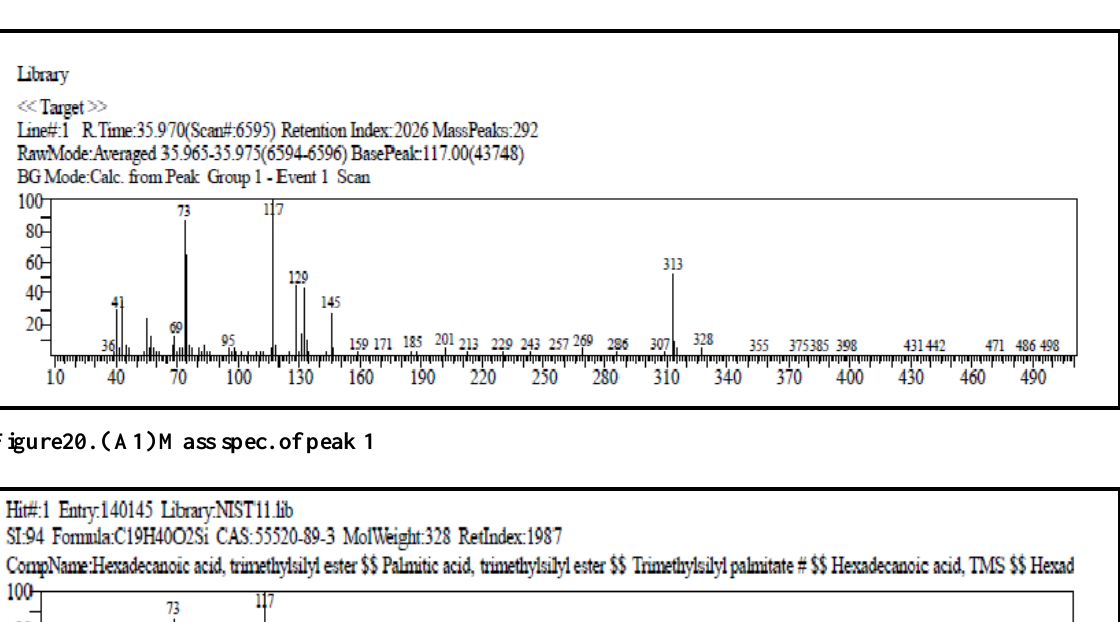
Figure 19.GC-MS of n-hexane fraction of Populus euphratica leaves